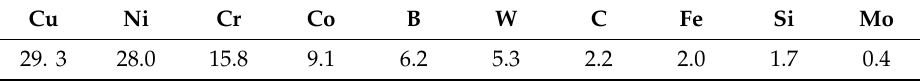
Figure 4. Scanning electron microscopy image ( a ) and distribution of all elements ( b ), Si ( c ), Cr ( d ) of the Ni–Co binding region. Table 2. Mass fraction of each element at the binding region of the Ni–Co coating (wt.%).